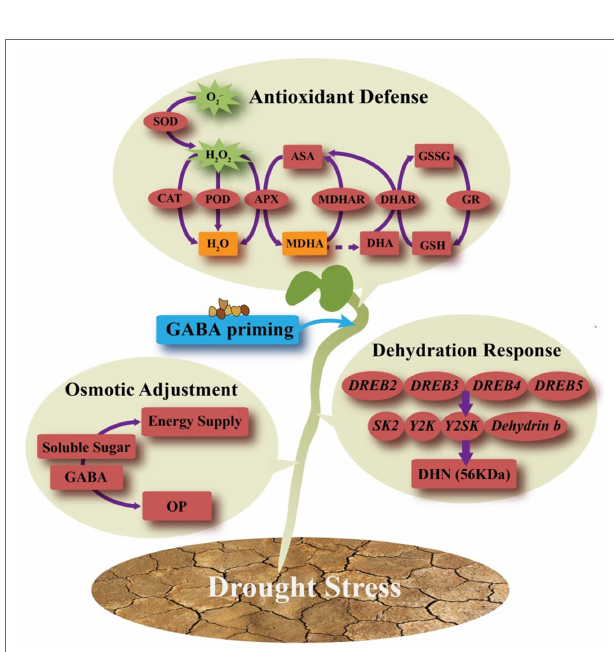
FIGURE 9 | Integrative pathways were regulated by the γ -aminobutyric acid (GABA) priming during seeds germination of white